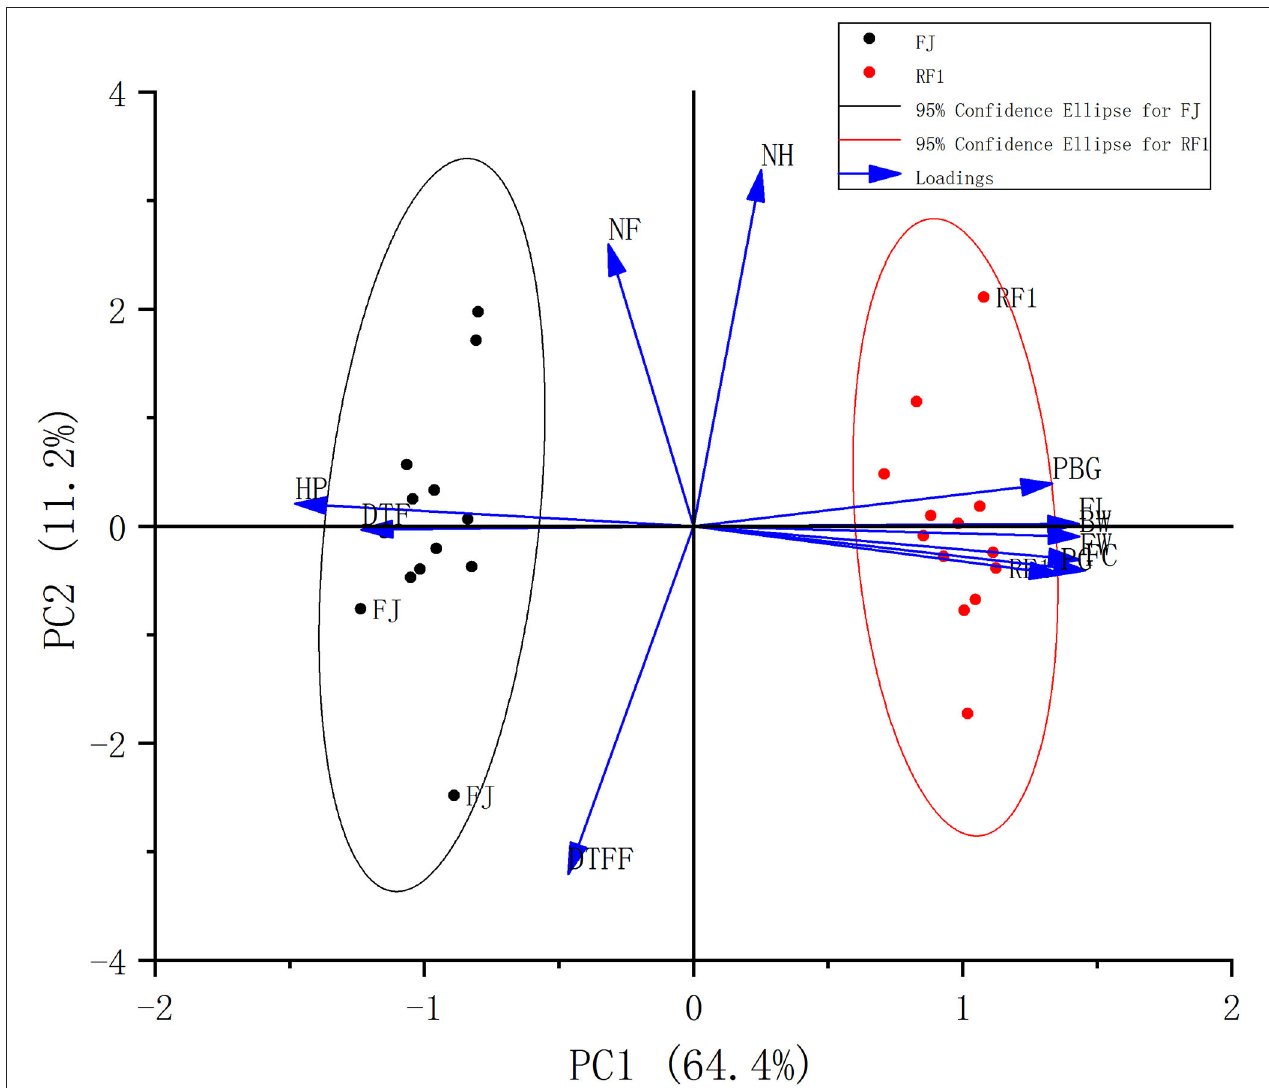
FIGURE 2 | Comparison of 11 agronomic traits between RF1 and FJ. The distribution of the agronomic traits plotted by principal components analysis (PCA). HP, the height of pseudo-stem; PBG, the plant base girth; PG, the plant girth; DTF, days to flowering; DTFF, days to fruit filling; BW, bunch weight; NH, number of hands; NF, total number of fingers; FW, fruit weight; FL, fruit length; FC, fruit